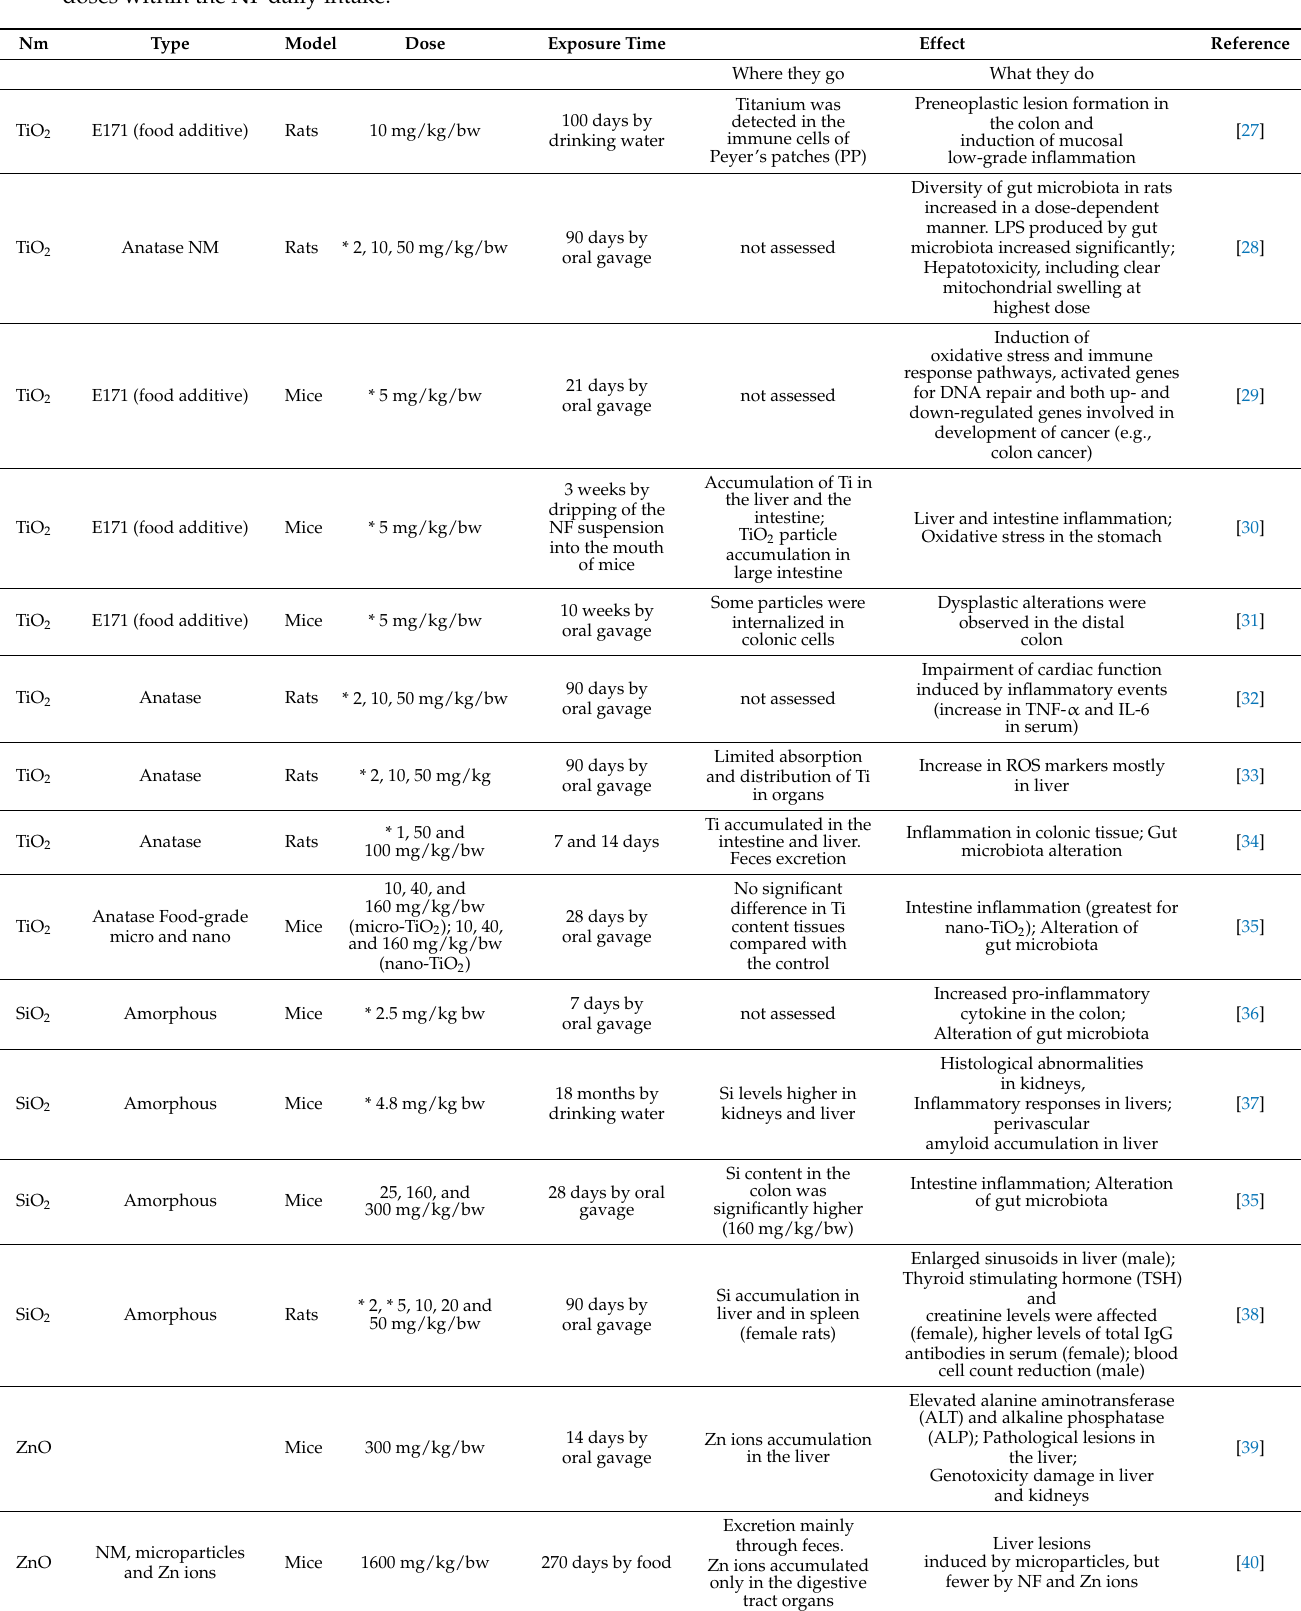
Table 2. Recent hazard data on the commonly ingested NMs. Only studies that consider oral exposure were selected. * doses within the NF daily